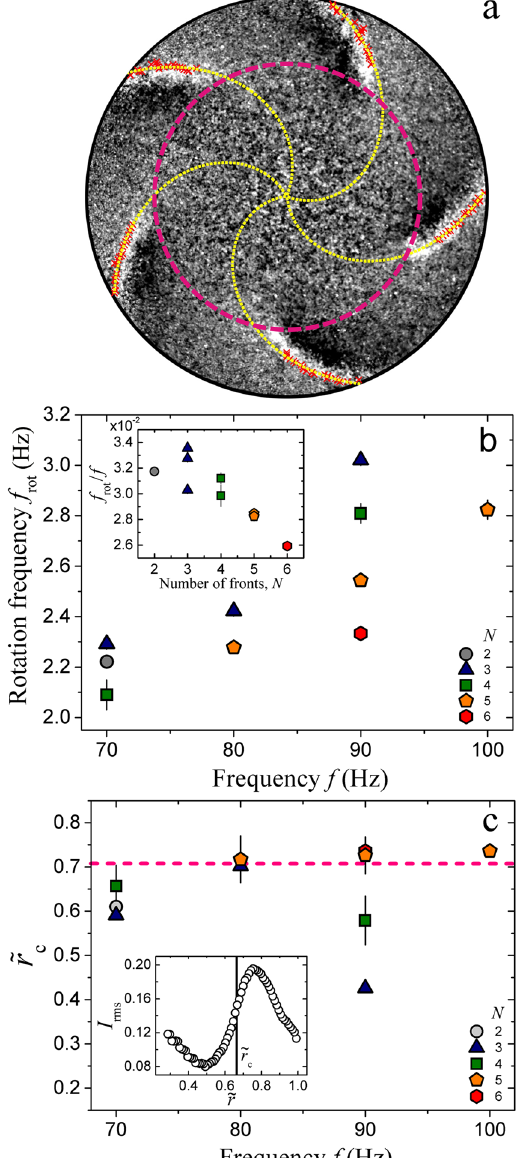
Figure 3. ( a ) A snapshot of four coherently propagating fronts captured with f = 80 Hz and Γ = 47.8. The fronts are identified as the peaks (red crosses) in the intensity profiles I ( θ ) along the azimuthal direction. The dotted curves are fits with Archimedean spirals originating at the container center. The dashed circle marks the critical radial distance r c . ( b ) Rotation frequency of the fronts f rot as a function of f for various N . Inset: Rescaled rotation frequency f rot / f for various N . ( c ) Rescaled critical radial distance  r as a function of f . The horizontal dashed line c marks =  r 1/ 2 . Inset: The level of intensity fluctuations I rms as a function of the rescaled radial distance r for c the image sequence corresponding to ( a ). Other parameters are the same as in Fig.